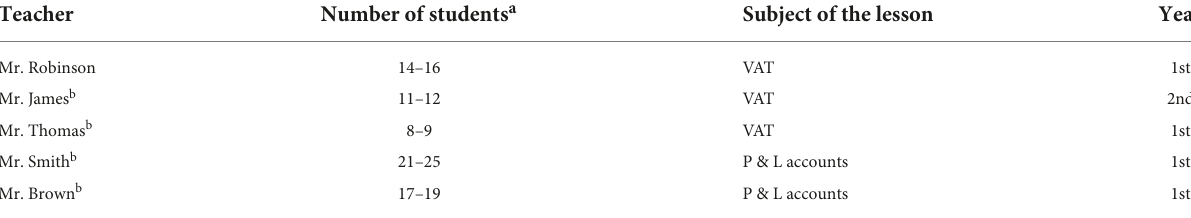
TABLE 1 Overview of participating teachers and